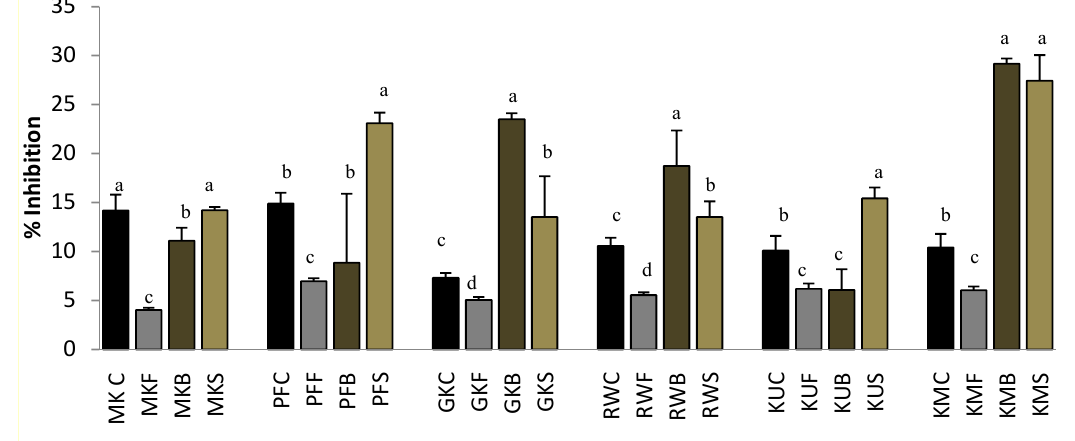
Figure 2. Heat-induced hemolysis inhibition ability of raw and cooked extracts of some GLV. Values represent means of triplicate readings. MK, O. zeylanica ; RW, C. auriculata ; KM, S. grandiflora ; KU, G. lactiferum ; PF, P. edulis ; GK, C. asiatica . C-fresh leaves; F-fried; B-boiled; S-steamed. Data are presented as means ± standard deviations of three replicate determinations. Columns with different letters for each vegetable are significantly different ( p < 0.05).